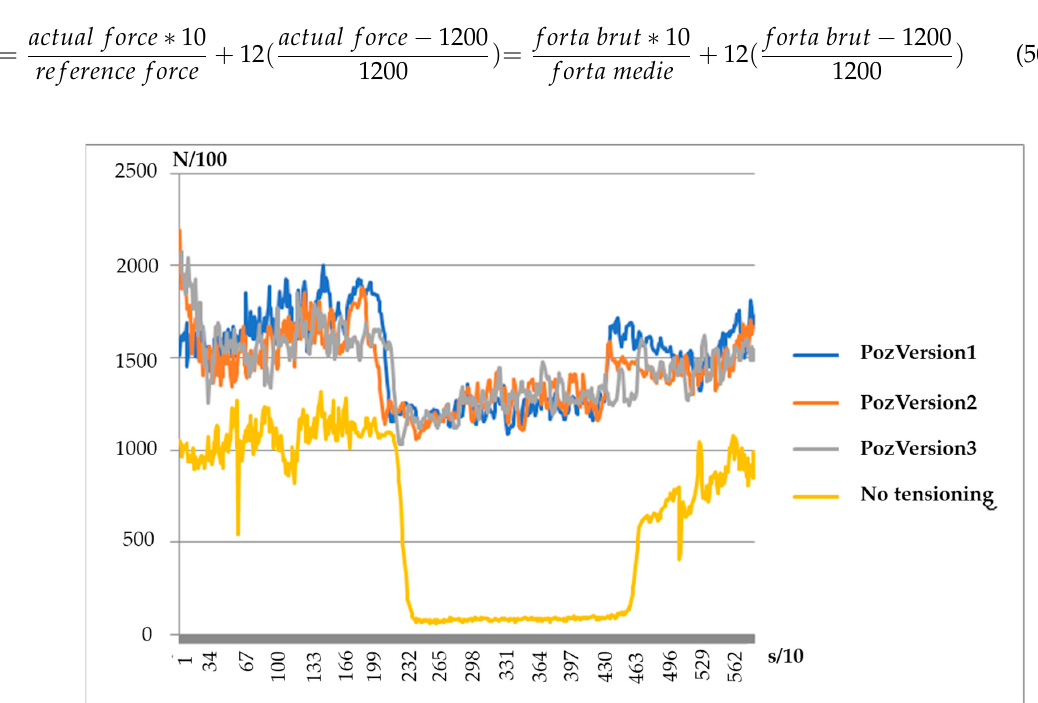
Figure 12. Preliminary tensioning tests.